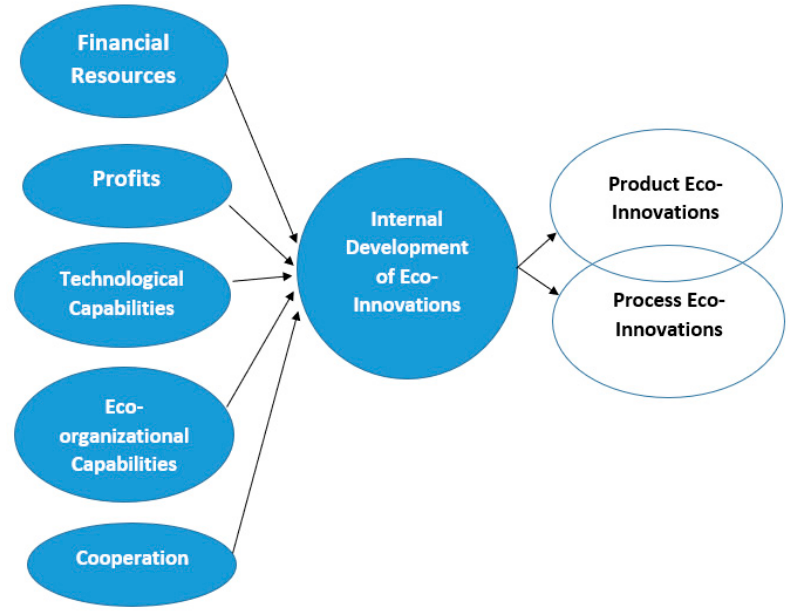
Figure 2. The influence of cooperative activities and the combination of resources and capabilities on the internal development of eco-innovations by